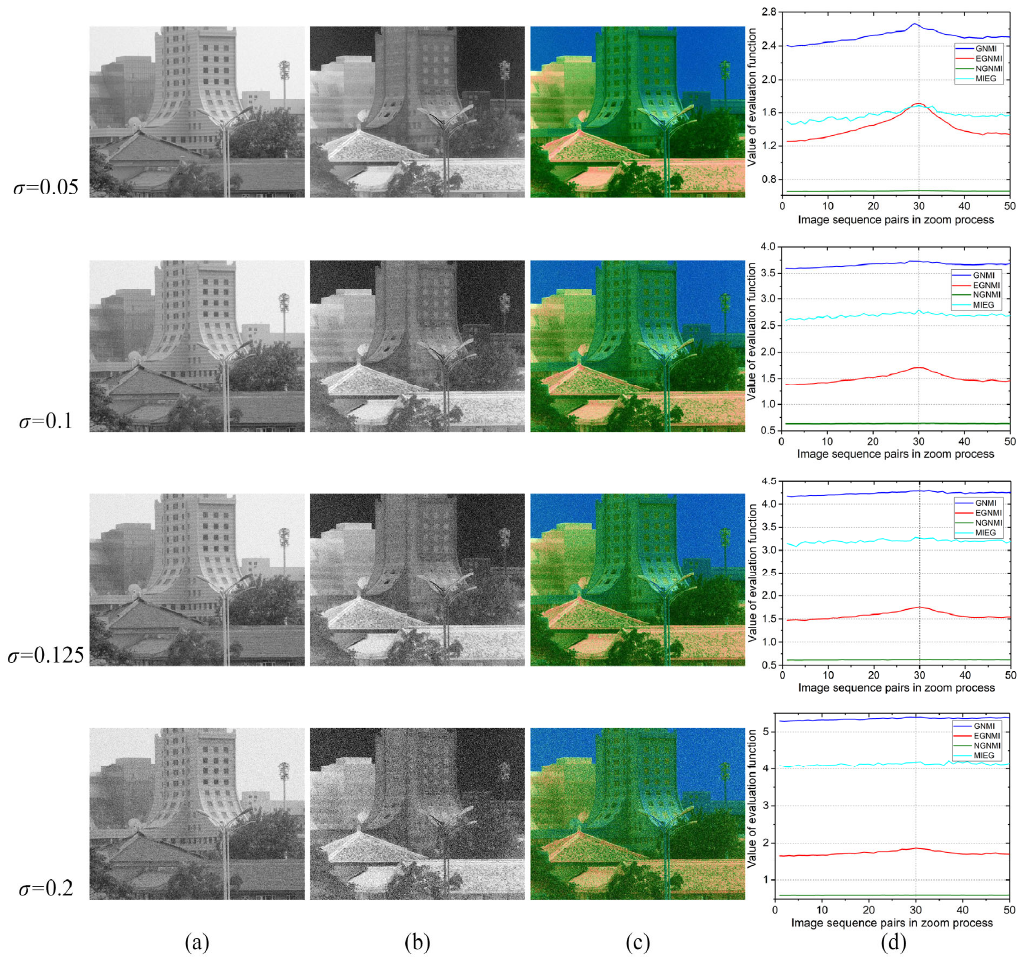
Figure 12. Results of noise experiments: ( a ) visible images; ( b ) infrared images; ( c ) color fusion images; and ( d ) evaluation function comparison.